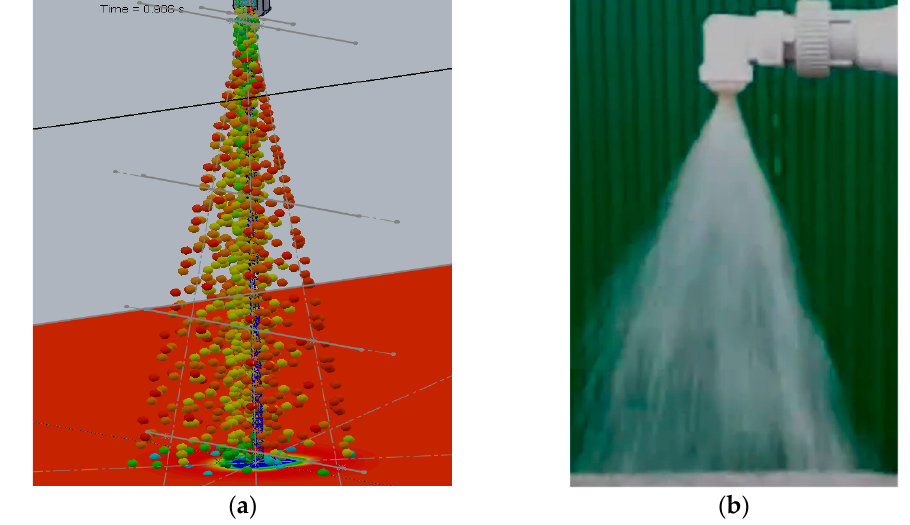
Figure 15. Visualization of the distribution of a steady liquid jet for a volume flow Q = 0.00025 m 3 /s. ( а ) Numerical calculation, ( b ) experiment.